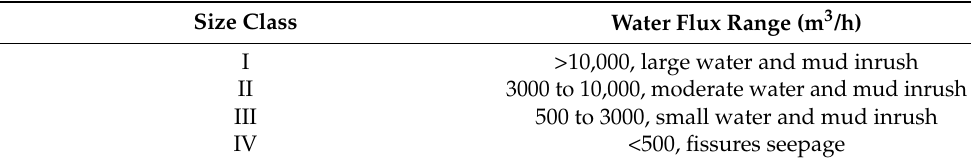
Table 4. Classification of water inrush in Karst tunnels.